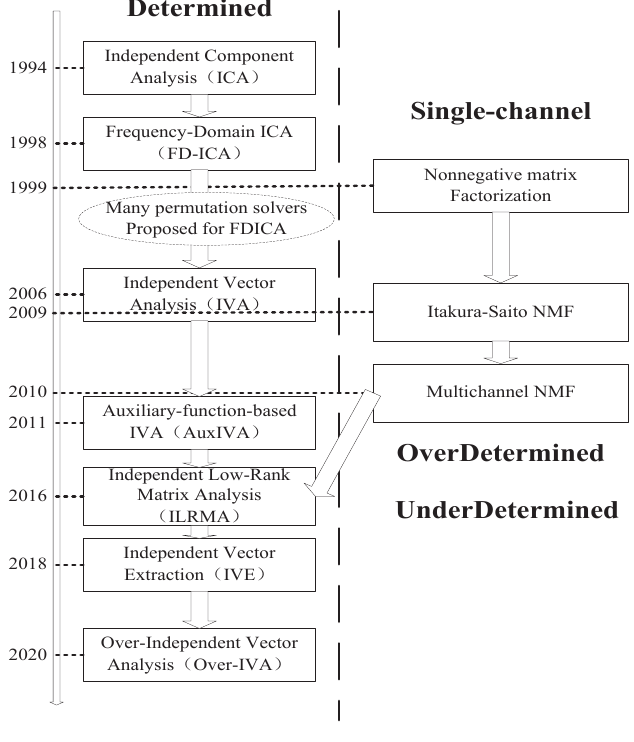
Figure 1. The history of